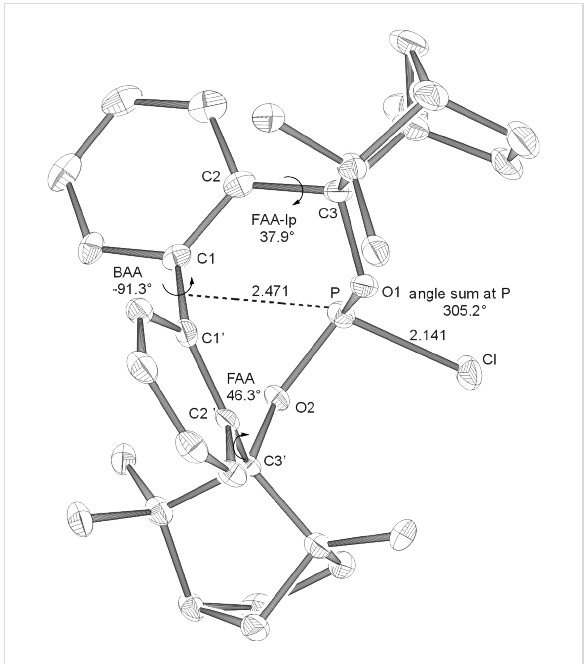
Figure 1: X-ray crystal structure of BIFOP-Cl ( 1 ). Distances are given in Å. (BAA = biaryl angle between C 2 -C 1 -C 1 '-C 2 '; FAA-lp = fenchyl-aryl dihedral angle between C 1 -C 2 -C 3 -O 1 ; FAA = fenchyl-aryl dihedral angle between C 1 '-C 2 '-C 3 '-O 2 ). The probability of ellipsoids is 40% (CDC 270531).